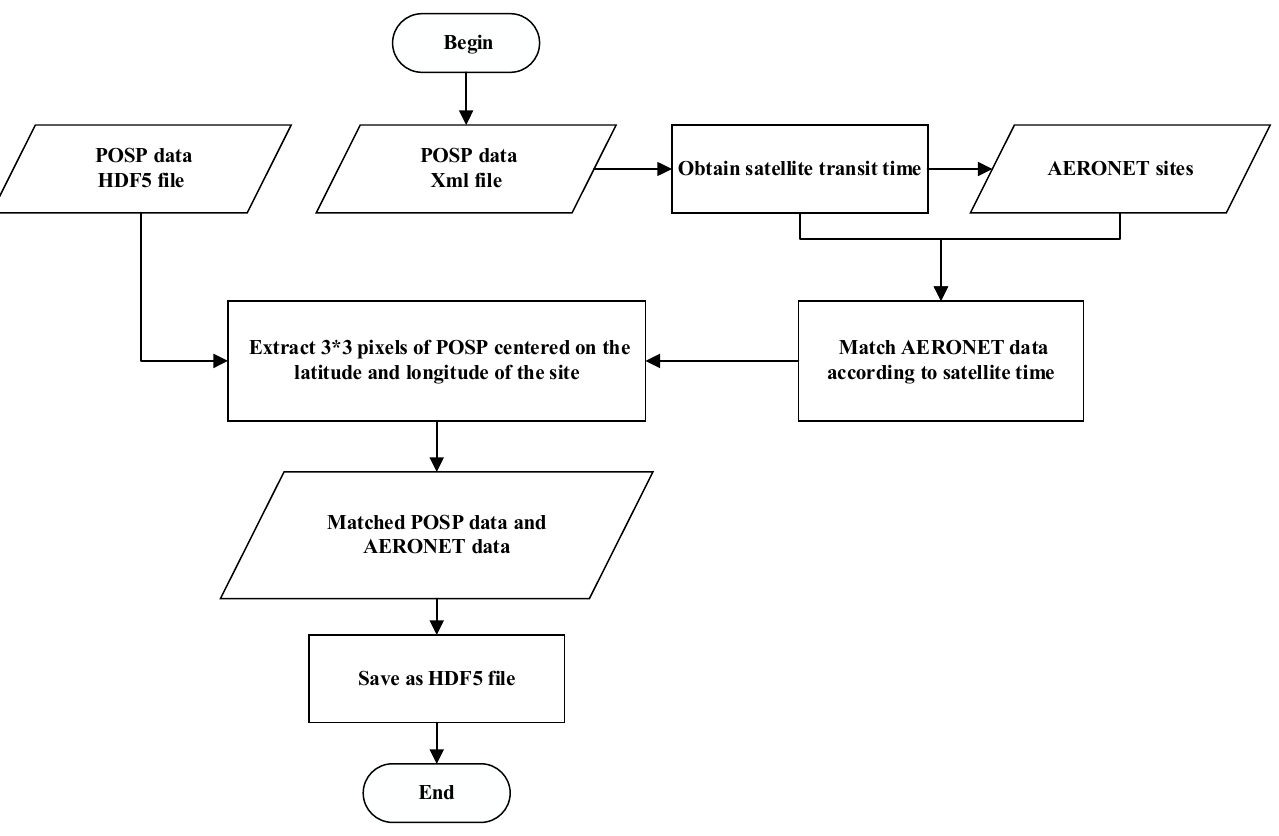
( d ) Taiwan Figure 5. Validation of the AOD at 670 nm with the proposed method against AOD at 675 nm in AERONET products at Beijing, Baotou, Hefei and Taiwan sites. It can be found from Figure 5 that the inversion results based on the algorithm proposed in this paper are basically consistent with AOD products of the AERONET sites,